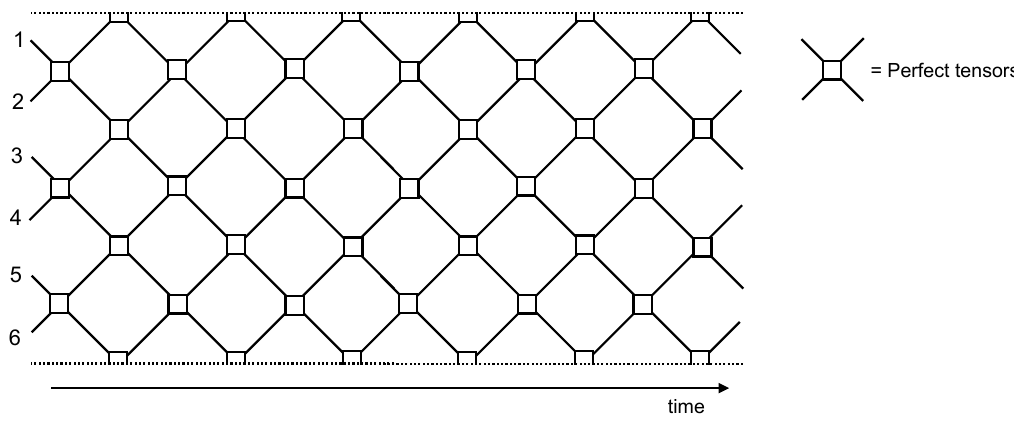
Figure 4 . A 6-qubit tensor network model for the geometry of the interior of a black hole. Via holography, the growth of the interior is expected to correspond to chaotic time evolution of a strongly coupled quantum theory. Here, each node corresponds to a perfect tensor and the numbers label the